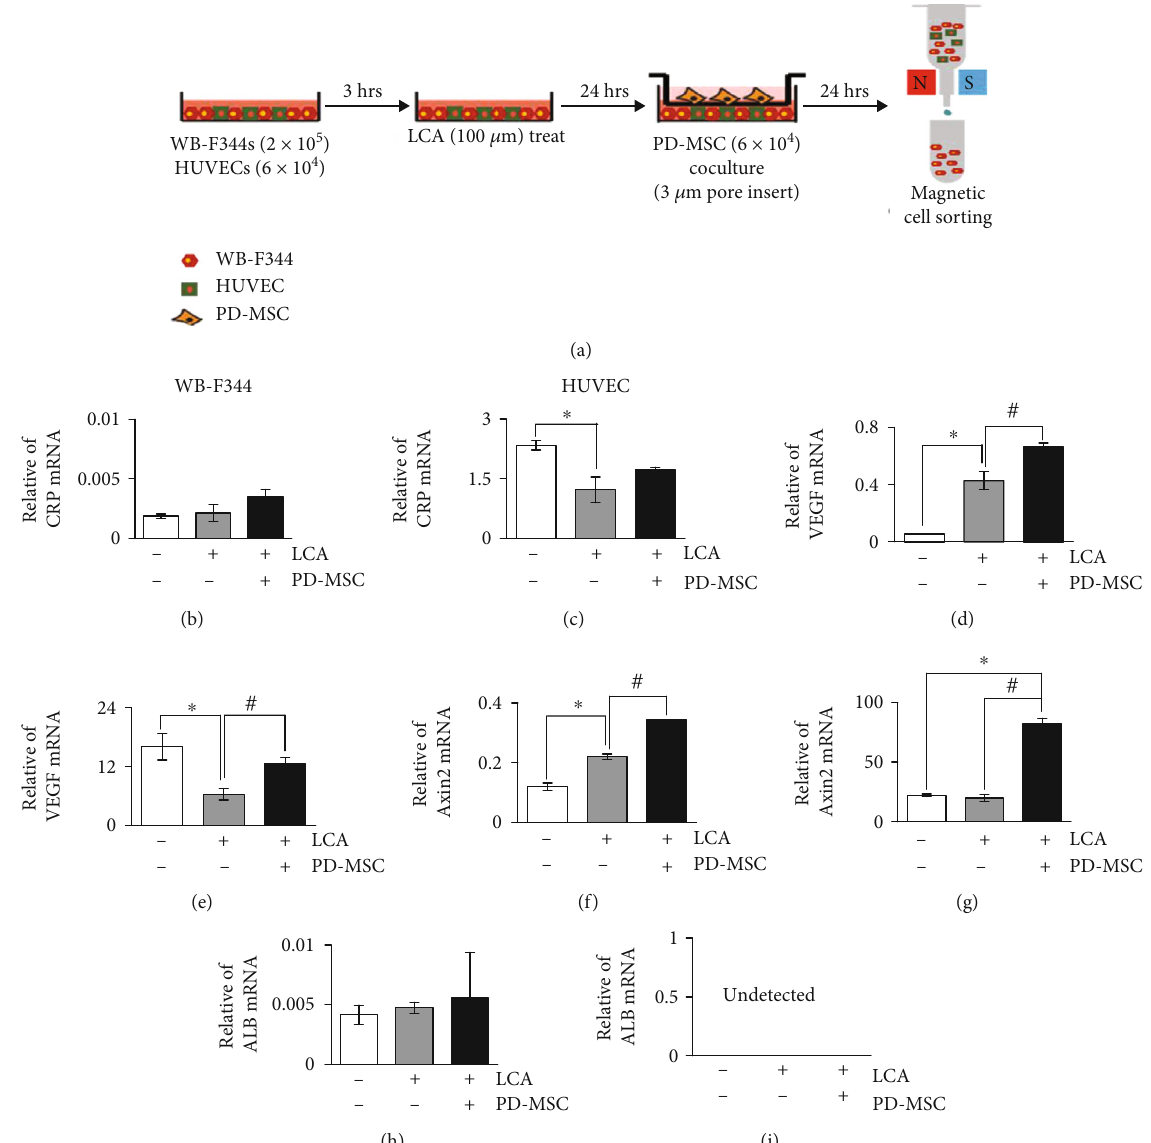
Figure 4: The e ff ect of PD-MSC for WB-F344 and HUVEC in the mRNA level. The scheme for experimental protocol is shown in (a). The mRNA levels of CRP (b), VEGF (d), Axin2 (c), and ALB (d) were analyzed in WB-F344s treated with LCA and cocultivated with HUVECs and PD-MSCs. The mRNA levels of CRP (c), VEGF (e), Axin2 (g), and ALB (h) were detected in HUVECs treated with LCA and cocultivated with WB-F344s and PD-MSCs ( n = 3 per group, ∗ control group and # LCA-treated group vs. p < 0 : 05 ). Data were represented as the mean ± SD . ALB: albumin; LCA: lithocholic acid-treated group; PD-MSC: PD-MSC cocultivated